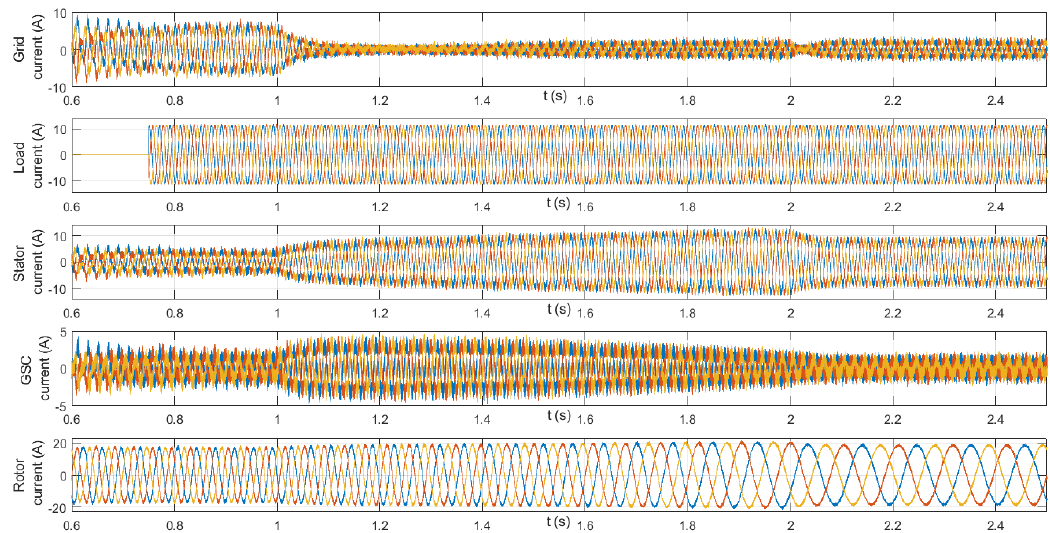
Figure 18. Grid, load, stator, grid side converter, and rotor currents for the process shown in Figure 17.